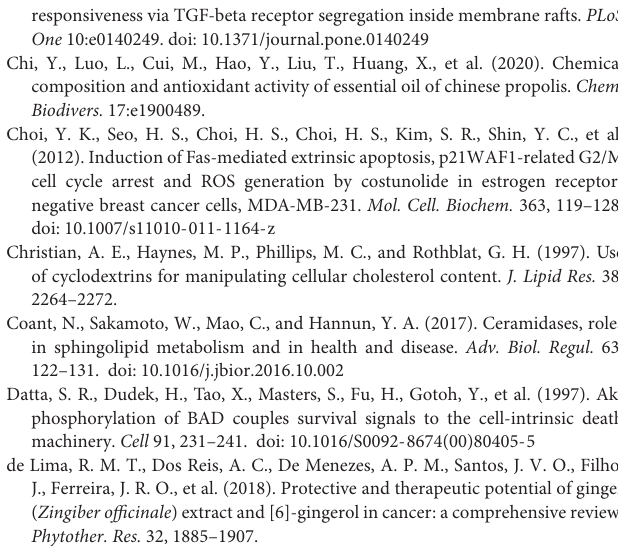
Supplementary Figure 1 | Effect of cedrol on cell cycle progression in K562 cells. K562 cells were treated with indicated concentrations of VH or cedrol for 18 h. Cells were treated with propidium iodide (PI) and then analyzed by flow cytometry. Percentage of cells in G1/G0, S, and G2/M phases were determined. Values represented on top of each box represent percentage of cells in difference phases of cell cycle (subG1: G1: S: